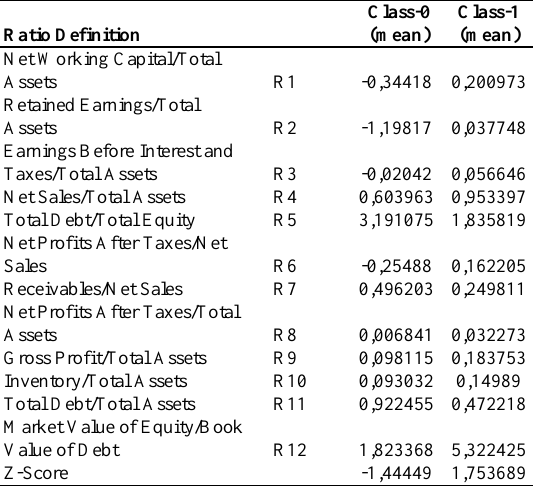
Figure 1. General flow of modelling process. Table 2. Mean values of the